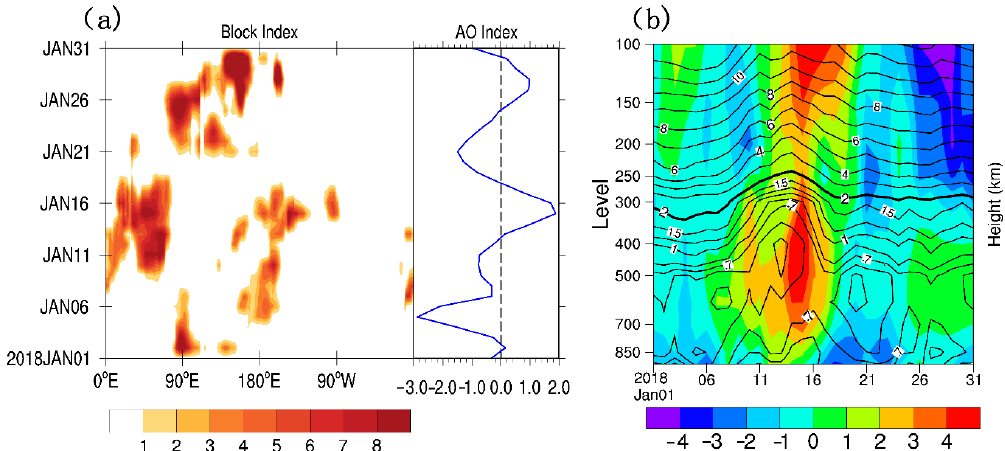
Figure 7. On January 2018 ( a ) PV − θ blocking index (left panel) and AO index (right panel); ( b ) diabatic heating in the Arctic (67–90° N) (shading, units: K day − 1 ) and the PV in Eurasian polar region (0–70° E, 70–90° N) (contours, units: PVU). Atmosphere 2020 , 11 , 215